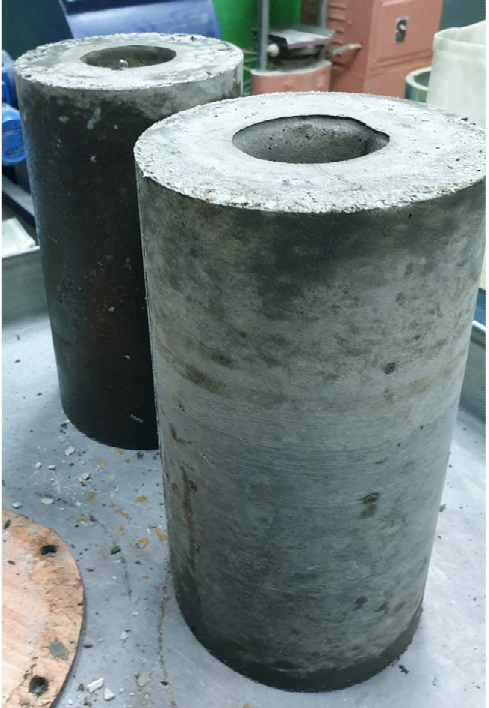
Figure 2. General view of the planetary ball mill “Activator—4M”.